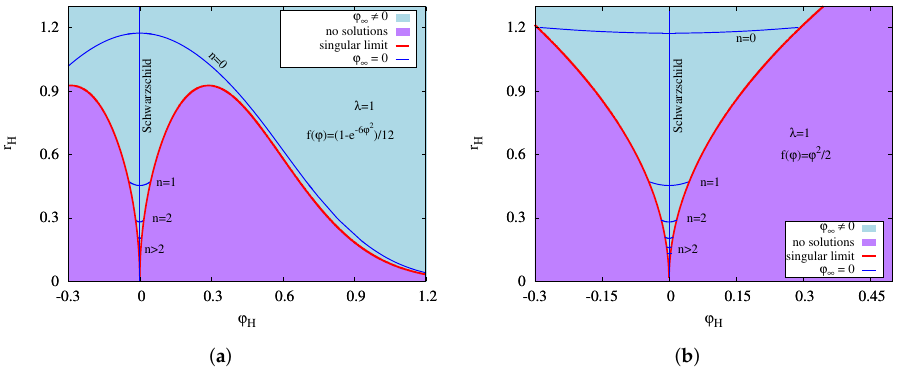
Figure 7. Polar l = 2 QNMs of dilaton GB black holes: ( a ) scaled frequency ω R / ω S coupling constant ζ = α / M 2 ; ( b ) scaled decay rate ω I / ω S and grav-led modes. The scaling is w.r.t. Schwarzschild [92].